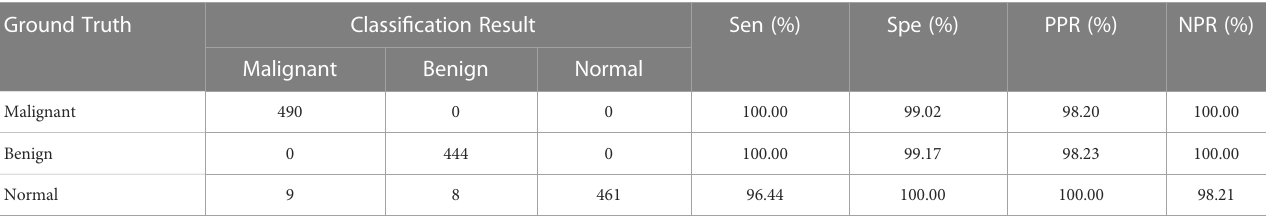
Normal ((d, n) = (20, 204)).